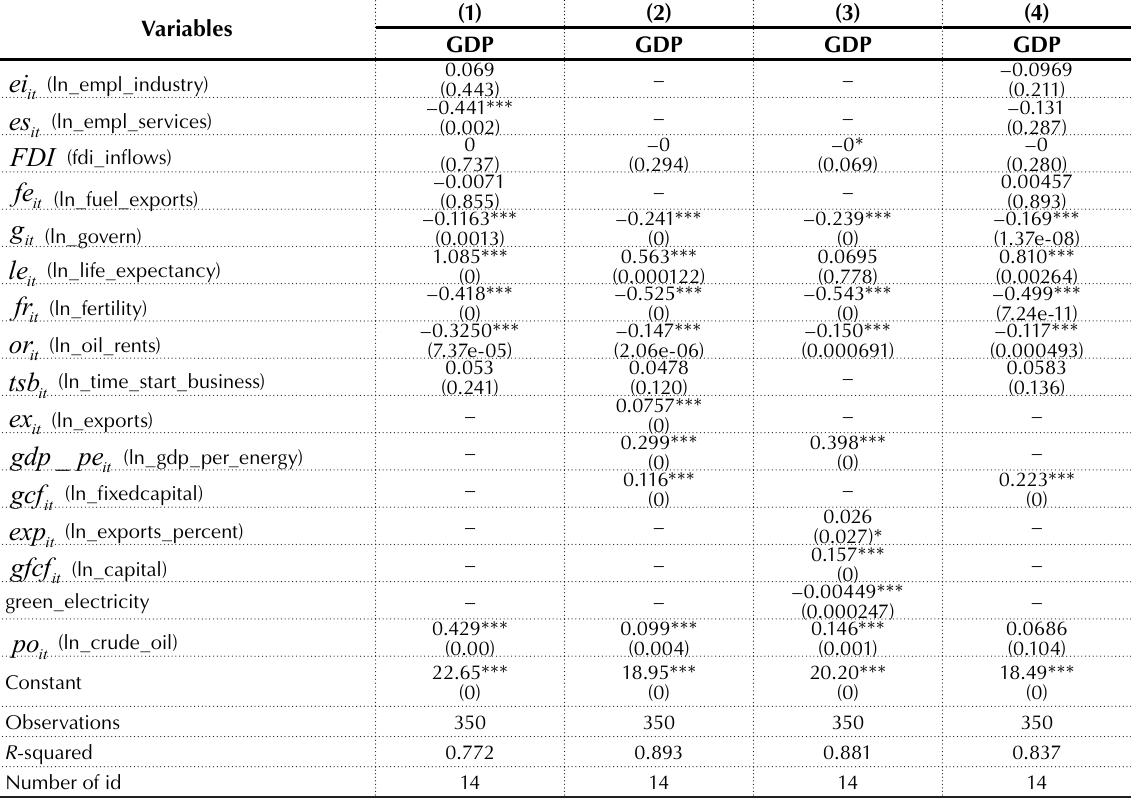
Table 2. The regression analysis of GDP drivers for the panel of 14 OPEC members